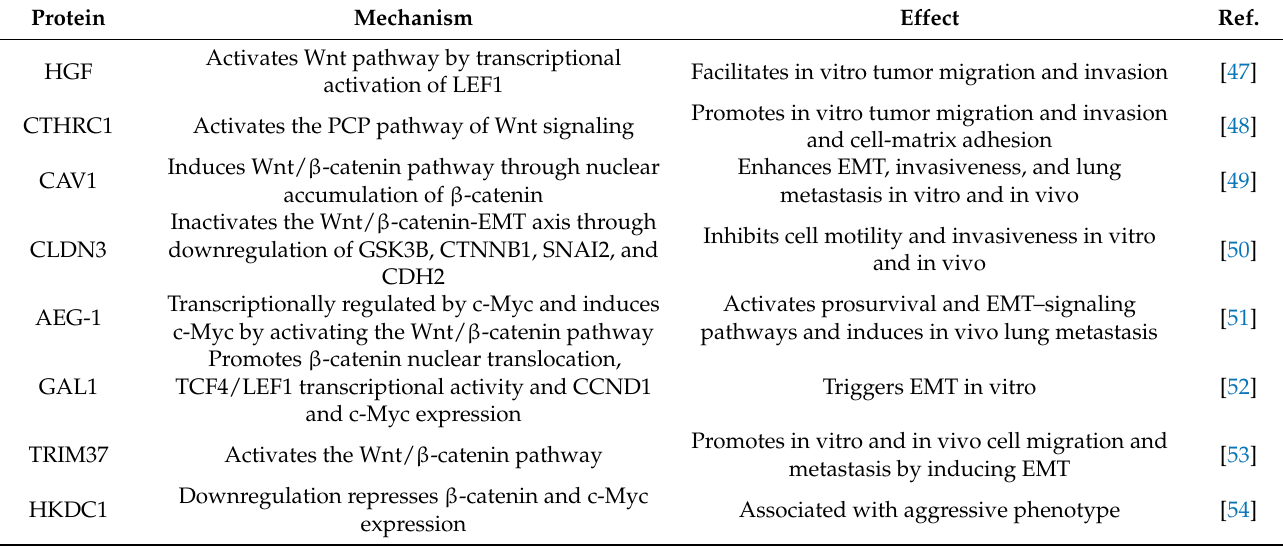
Table 1. Proteins that converge to the Wnt signaling pathway and in that way influence epithelial-mesenchymal transition (EMT), motility, migration, invasion, and metastasis of hepatocellular carcinoma (HCC). The publications are listed in chronological